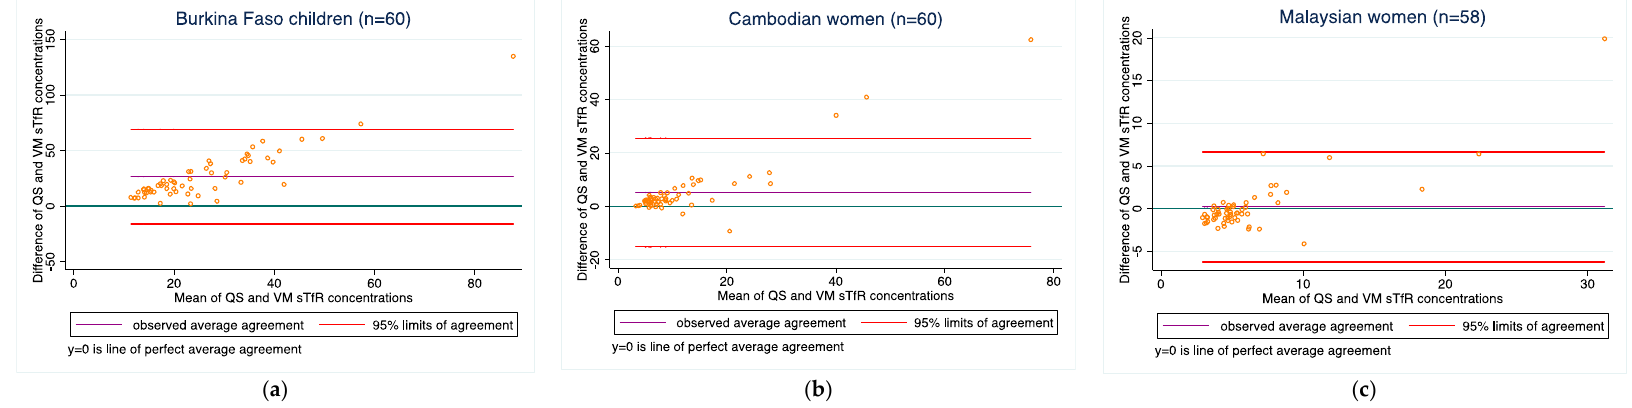
Figure 2. STfR concentrations for ( a ) Burkina Faso children ( n = 60); ( b ) Cambodian women ( n = 60); and ( c ) Malaysian women ( n = 58).